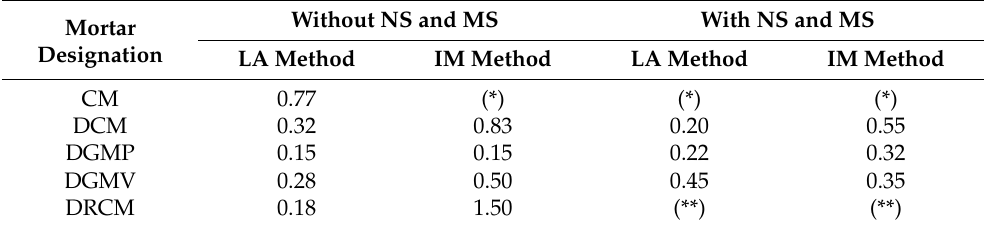
Table 6. The average values of the maximum crack width (mm) in mortar after testing.